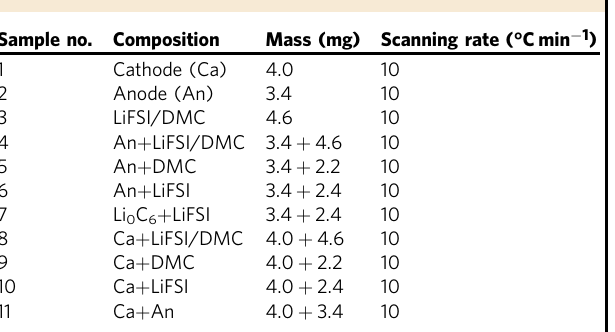
Table 2. These eleven samples covered the key exothermic reactions in the bat- tery 33 . In the DSC results, the heat fl ow was normalized by the total weight of Ca + An + LiFSI/DMC, which was calculated based on the measured weight of the test sample and the corresponding weight ratio of the test sample in Ca + An + LiFSI/ DMC. The composing proportion of Ca + An + LiFSI/DMC is the same as that of the full cell. By these means, the peak intensity implies the heating effect on the Table 2 Samples for DSC-TG-MS